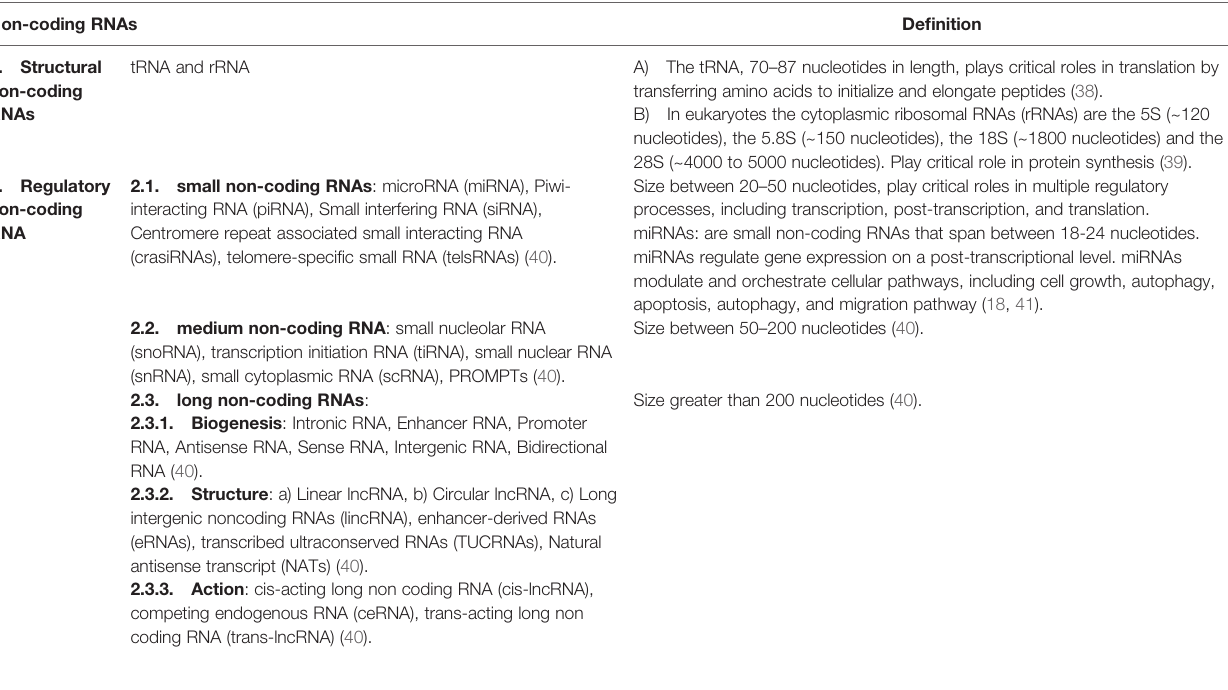
TABLE 1 | Classi fi cation of non-coding